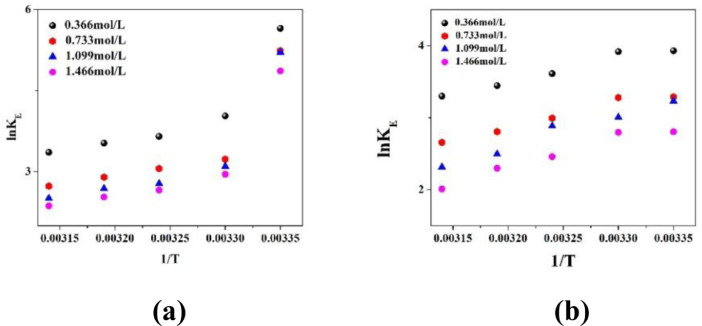
Variation of lnKEwith1/Tusing (a) Sunflower oil and (b) Soybean oilas diluents. TBP concentration is varied in the range of 0.366 to 1.466 mol/L.